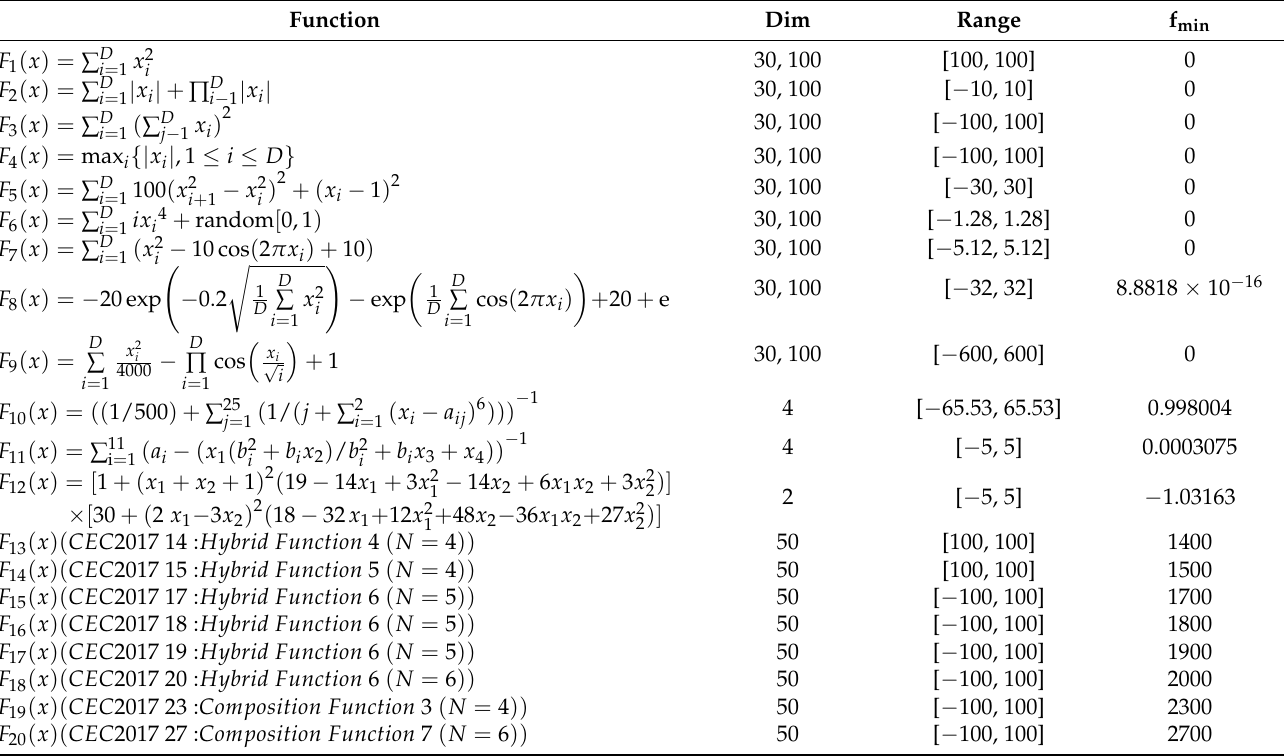
Table 1. Benchmark functions.